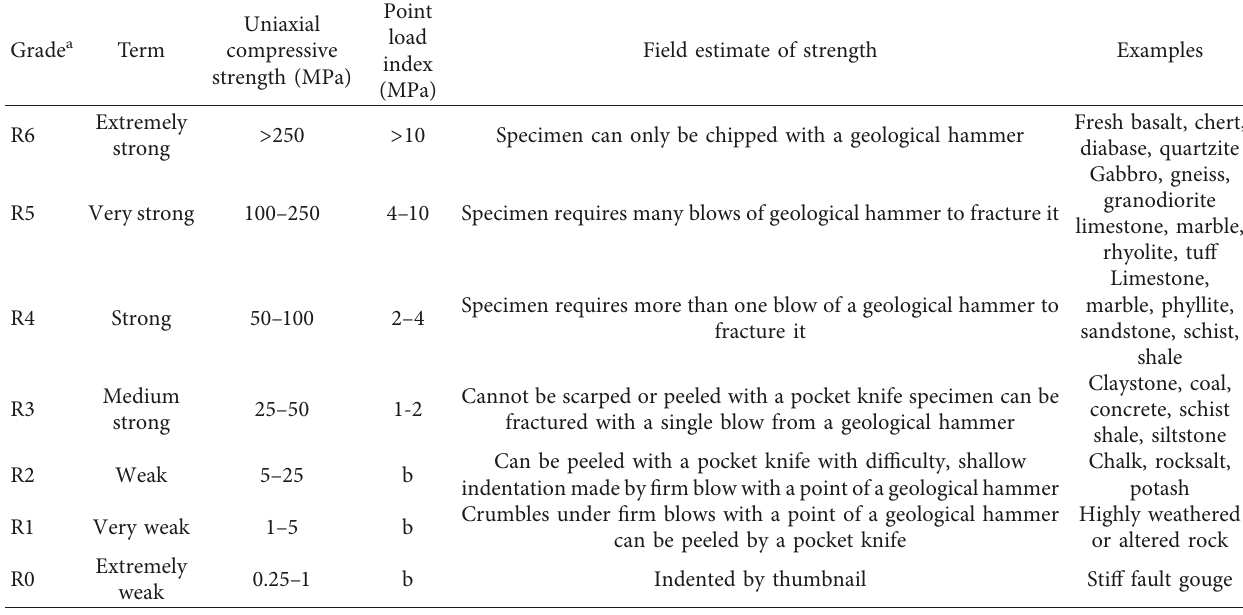
Table 2: The field estimates of the uniaxial compressive strength of intact rock pieces, Hoek et al.